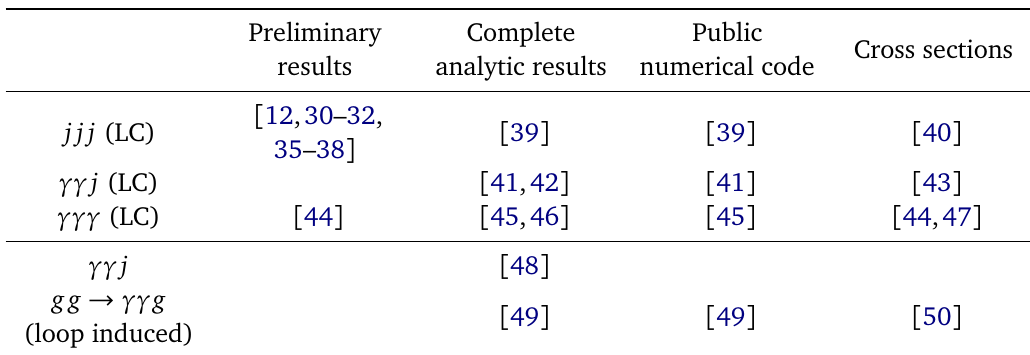
Table 1: Summary of the known two-loop QCD corrections for massless five-point scattering processes at hardon colliders. All public codes employ PentagonFunctions++ [ 33 ] for numerical evaluation of special functions. (LC) marks the processes in the leading-color